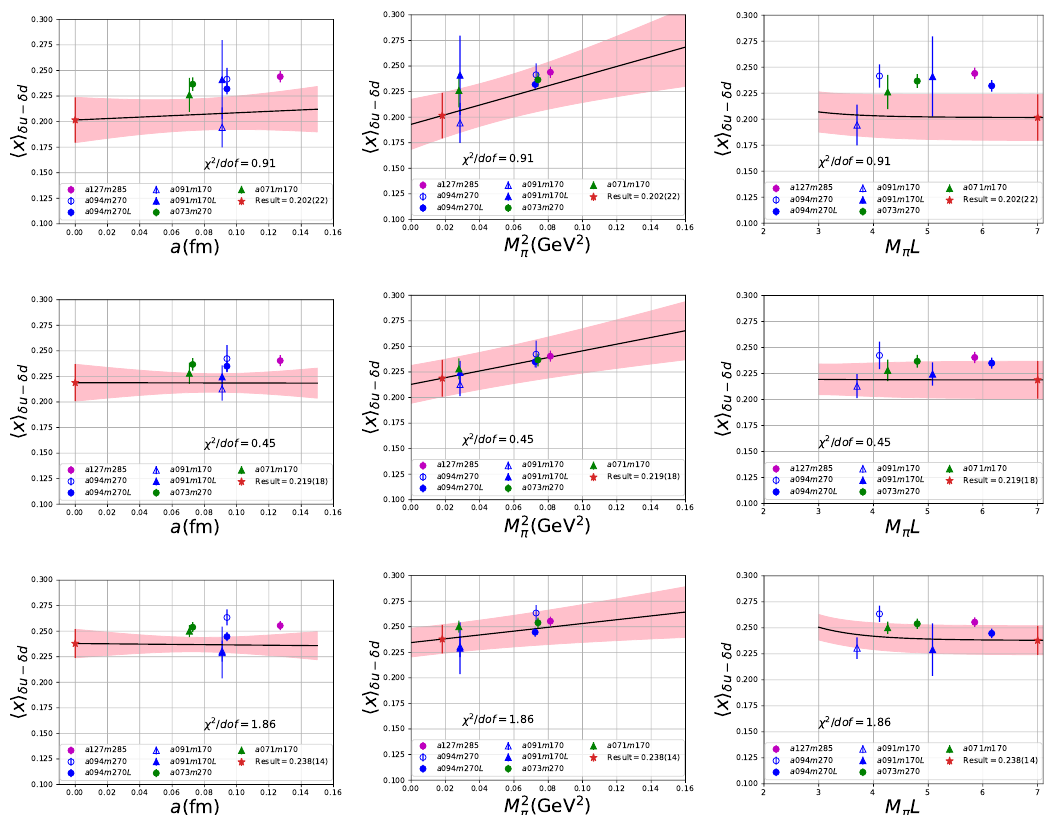
Figure 3 . Data for the transversity moment h x i δu − δd from the seven ensembles renormalized using method A in the MS scheme at µ = 2 GeV. The rest is the same as in figure